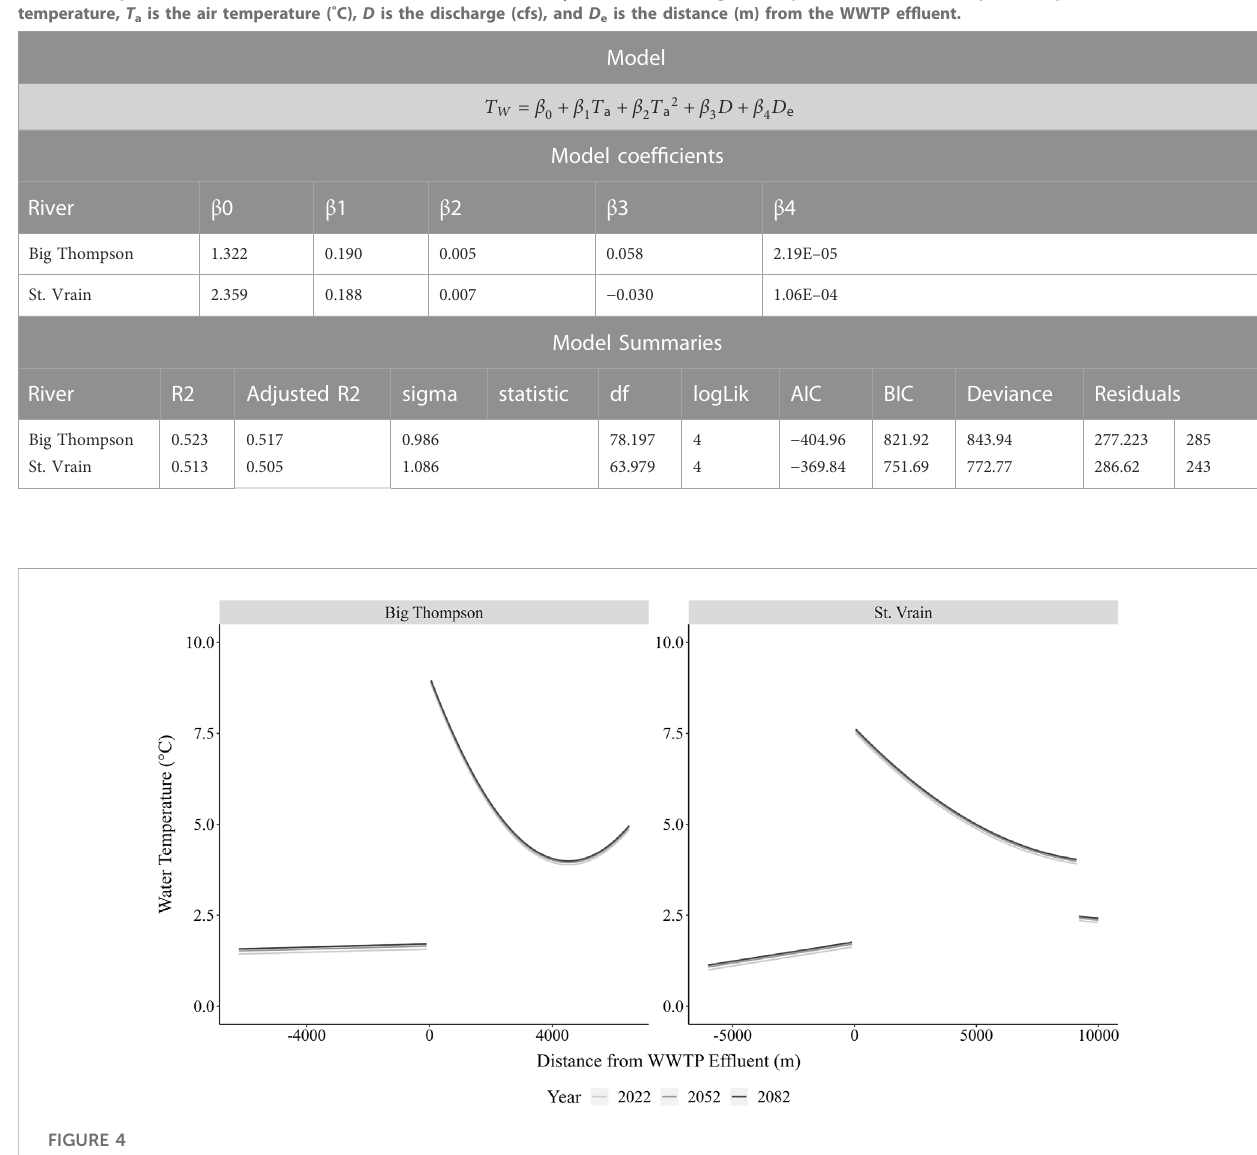
Predicted winter water temperatures in the Big Thompson and the St. Vrain under 2022, 2052, and 2082 winter air temperature conditions from coef fi cients in the upstream and downstream winter water temperature models (Table 1; Table